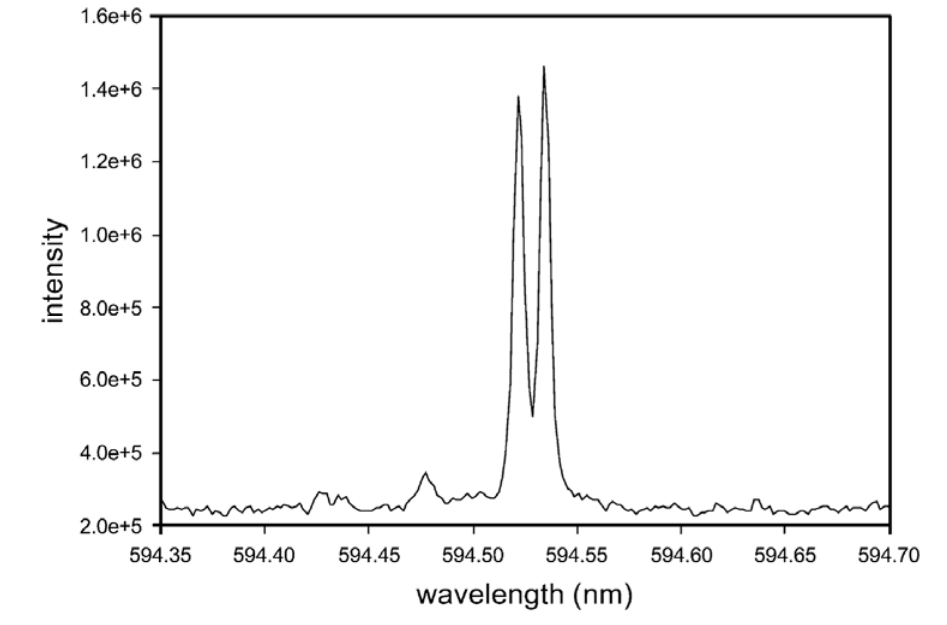
Figure 15. LIBS spectrum of plutonium oxide 239 Pu (49%) and 240 Pu (51%). Reprinted from reference